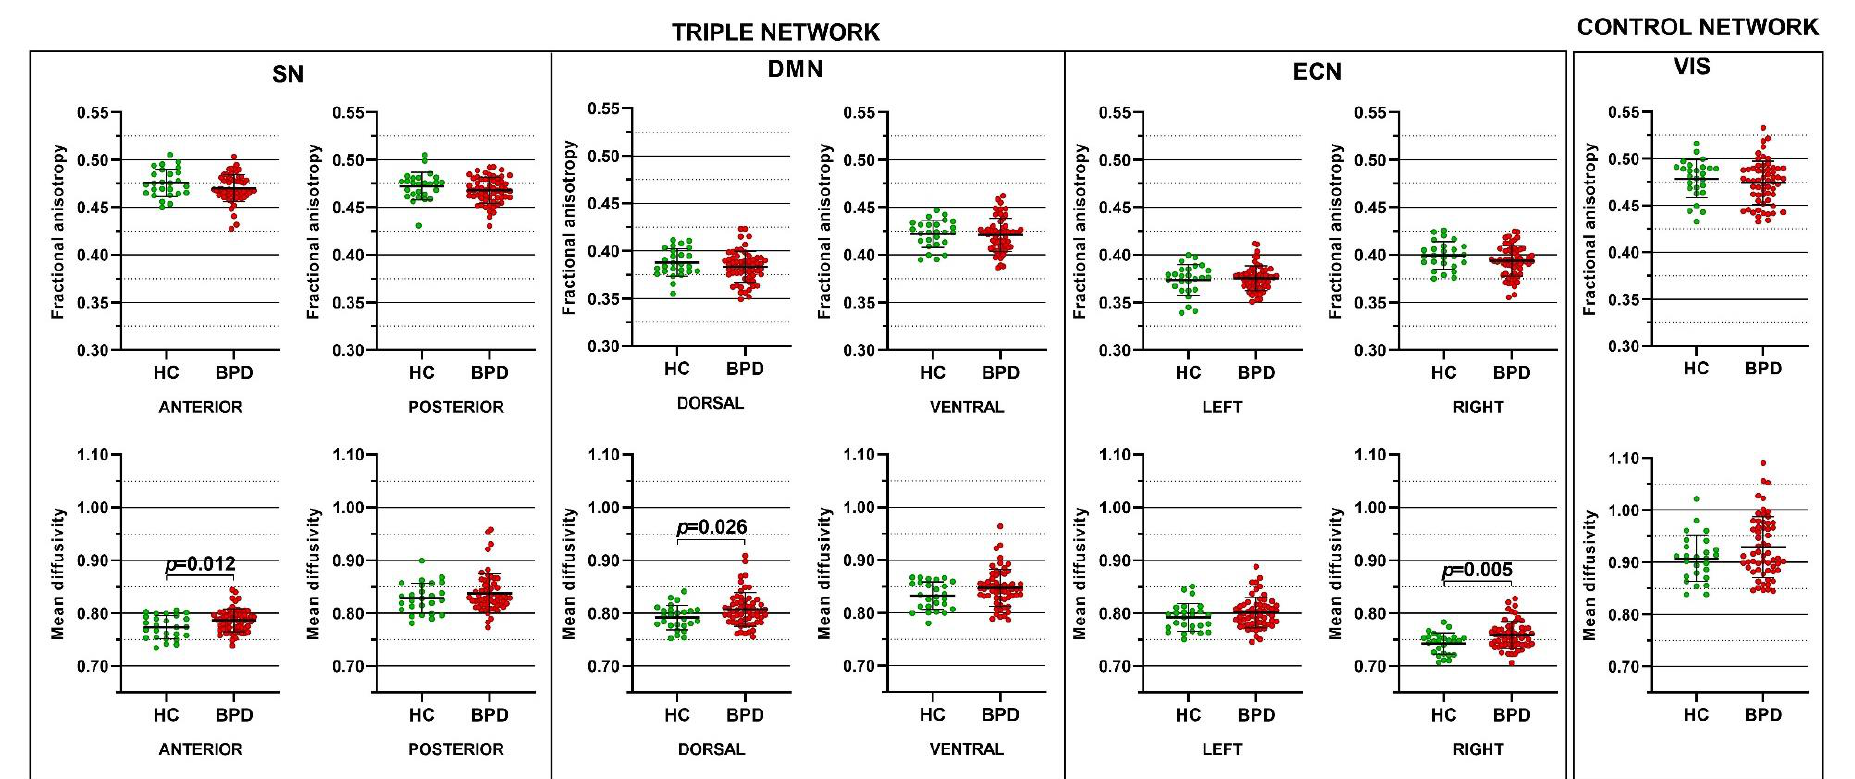
Figure 1. Differences in fractional anisotropy and mean diffusivity of the salience network (SN), default mode network (DMN), executive control network (ECN), and visual network (VIS) in Borderline Personality Disorder (BPD) compared to healthy control (HC). Each dot represents a subject, horizontal and vertical bars denote the mean and the standard deviation, respectively. p values denote the statistical significance, corrected for multiple comparisons using the Bonferroni method.